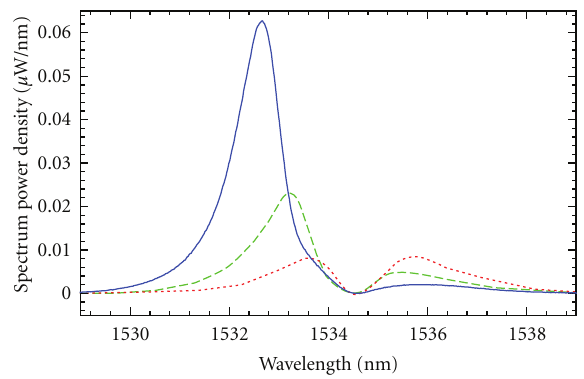
Figure 5: Measured spectra corresponding to the synthesized wave- forms in Figure